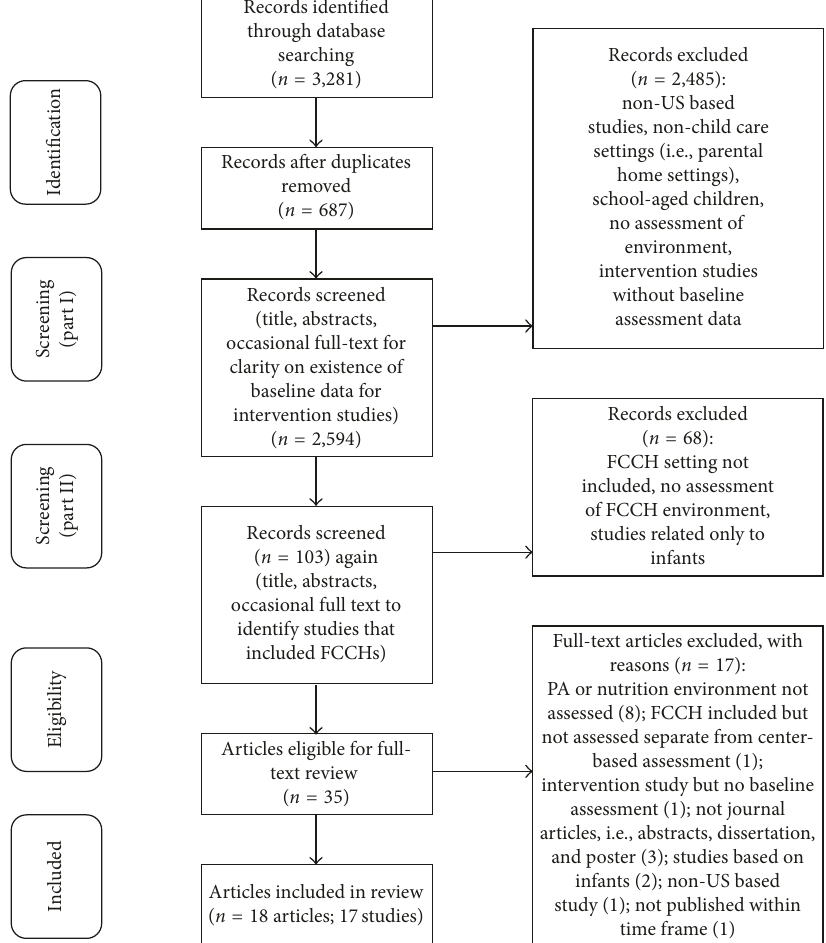
Figure 1: Preferred reporting items for systematic and meta-analyses diagram depicting the flow of